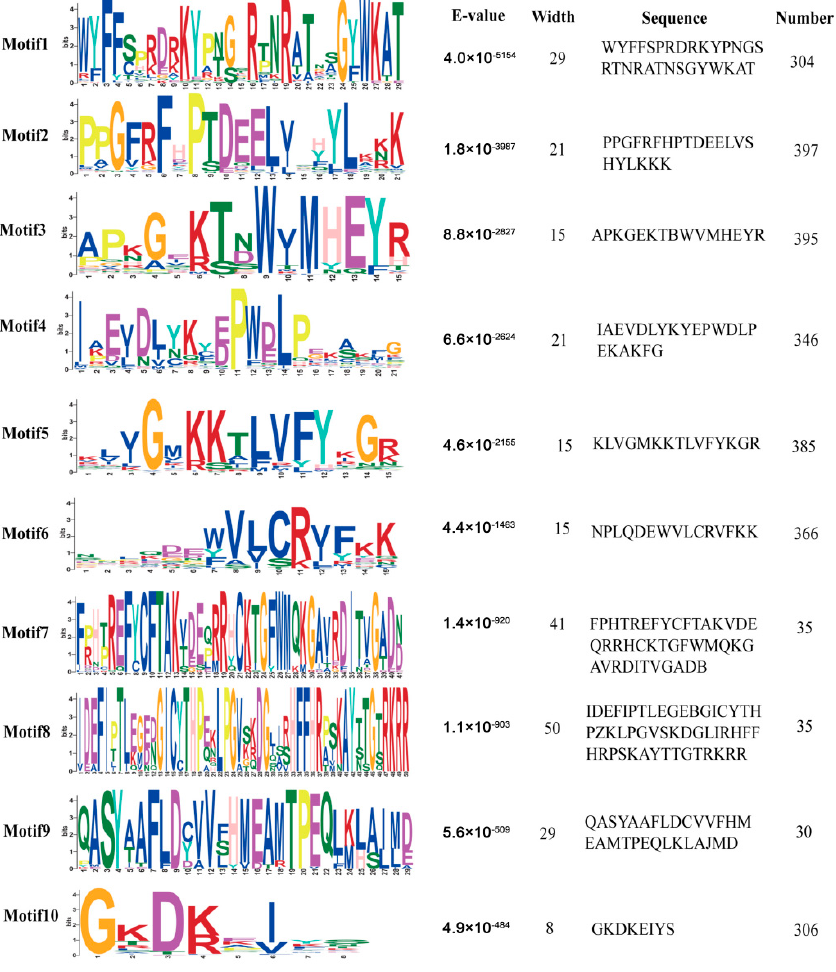
Figure 2. Conserved motif information for MsNAC proteins.